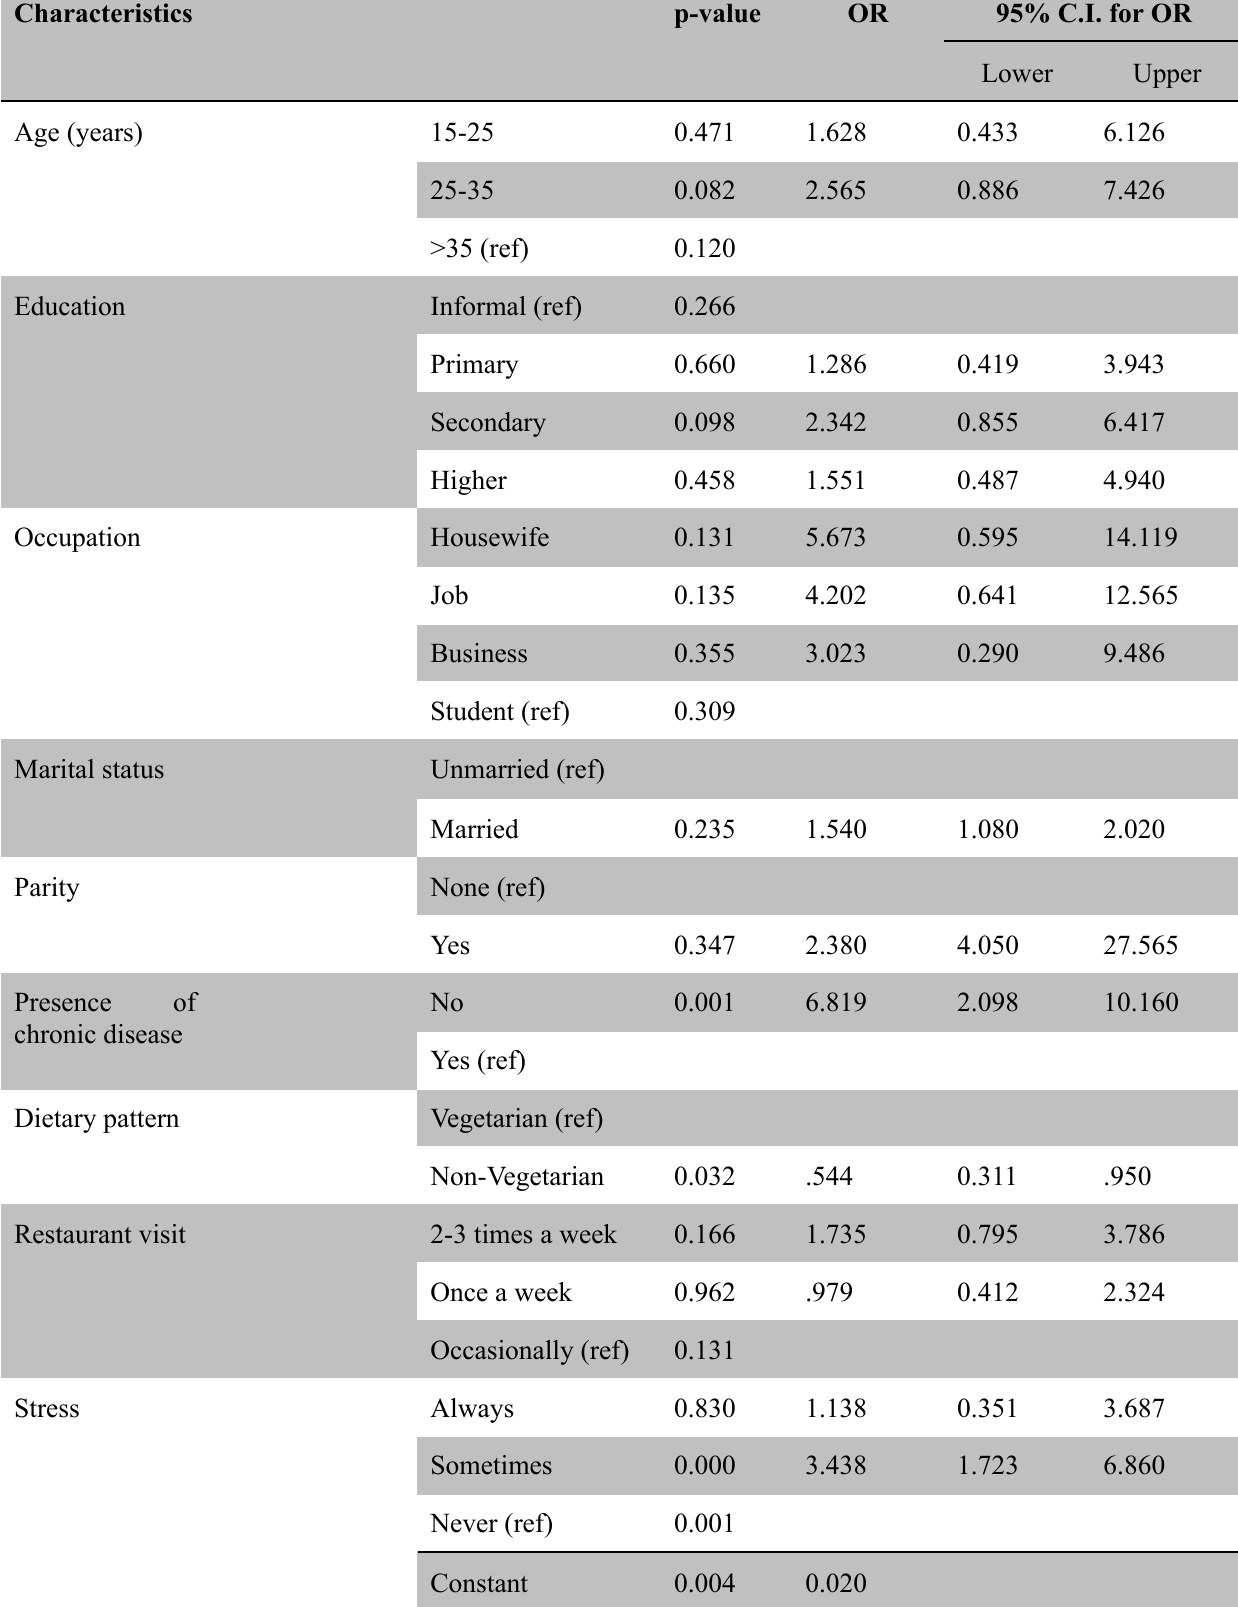
Table 6: Logistic regression of BMI for different characteristics